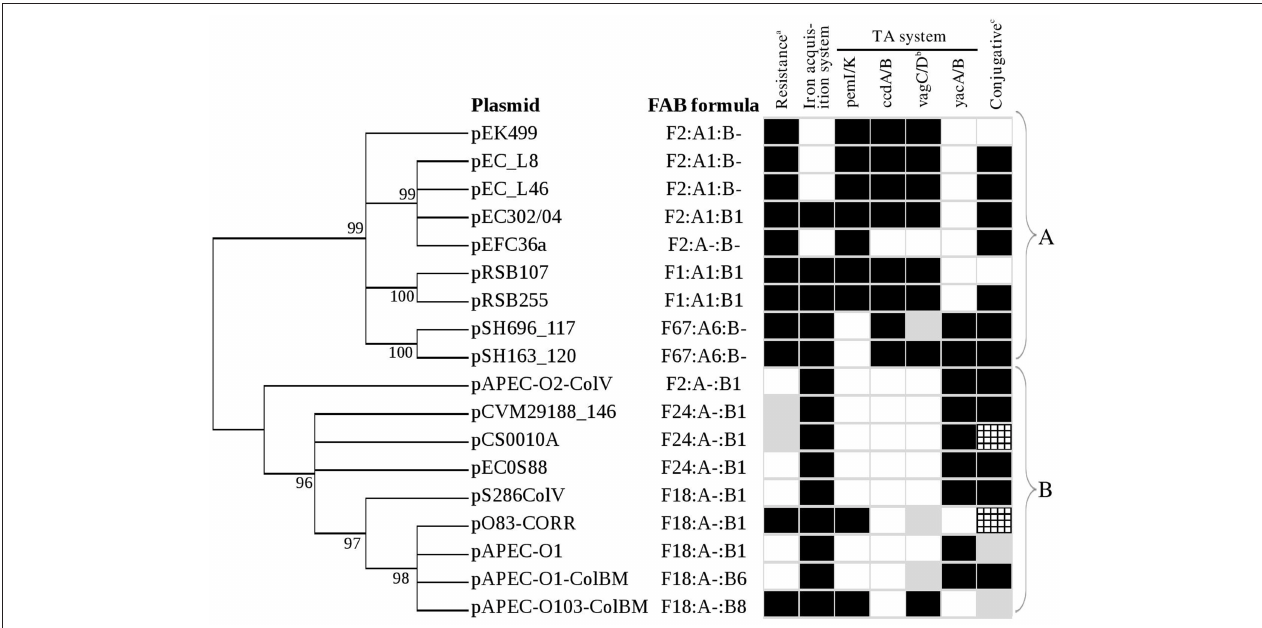
FIGURE 4 | Phylogenetic tree of RepFII repA1 gene from 18 IncFIIA plasmids. Core genome determination using both PGAP and Hal phylogenomics revealed that repA1 is the only gene conserved in all 18 plasmids. Trees constructed using output of PGAP and Hal phylogenomics are similar. Maximum likelihood (ML) method under the General Time Reversible plus Gamma model was used to construct the phylogenetic tree using MEGA5 supported with bootstrapping (1000 replicates). Bootstrap value with percentages equals or greater than 50% were shown on the branches and value less than 50% have been collapsed. FAB formula (F-:A-:B-) are indicated. All non ColV/BM plasmids were grouped together at cluster A and while all ColV/BM plasmids were grouped at cluster B. Black and white boxes indicate the presence and absence of specific plasmid features. Gray boxes ab indicate the presence of specific plasmid features but are located at atypical plasmid sites. c The ability to transfer for each plasmid was retrieved from their respective studies. Gray boxes c indicate that the ability of the plasmid to transfer has not been reported before. Checkered gray boxes c indicate that the plasmid is only transmissible in the presence of other plasmid and is not self-transmissible.